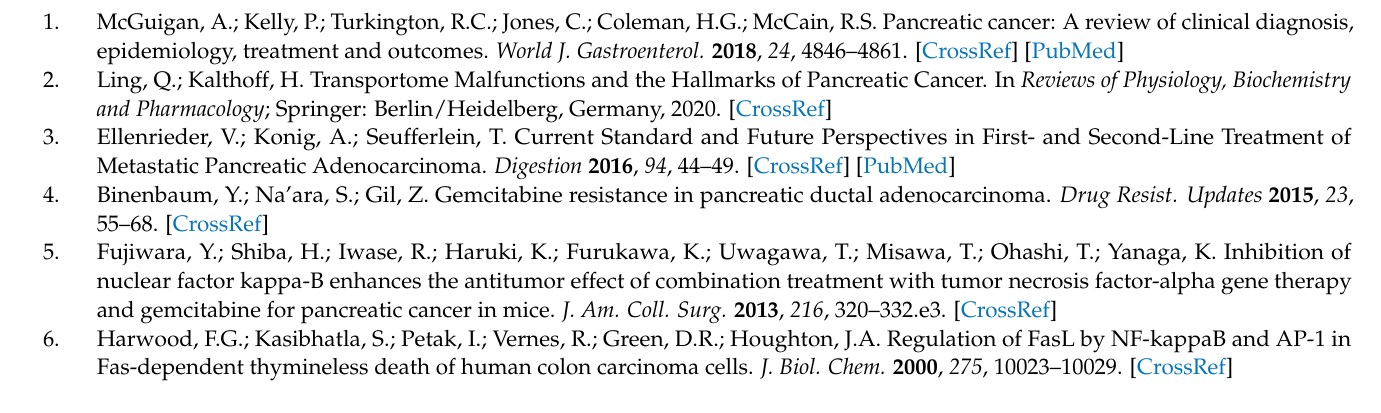
Figure S3: Inhibitory Effects of sCD95Fc on the Gemcitabine-induced expression of CD95 and CD95L in pancreatic tumor cells, Figure S4: Pancreatic tumor volume after cell inoculation in a palliative therapy setting, Figure S5: Inhibitory effects of sCD95Fc on uPA, MMP7 and MMP9 mRNA and protein expression in pancreatic cancer cell lines upon TNF α , TRAIL and rCD95L treatment, Human PDAC cell line PancTuI-luc was seeded with 2.8 × 10 5 cells/well in a 6-well plate, Table S1: List of the PerfectProbe primers used in qPCR, Table S2: Schematic overview on our findings using two distinct pancreatic tumor cell lines PancTuI-luc and A818-4 as model cell lines obtained from two different sources such as primary tumor and ascites